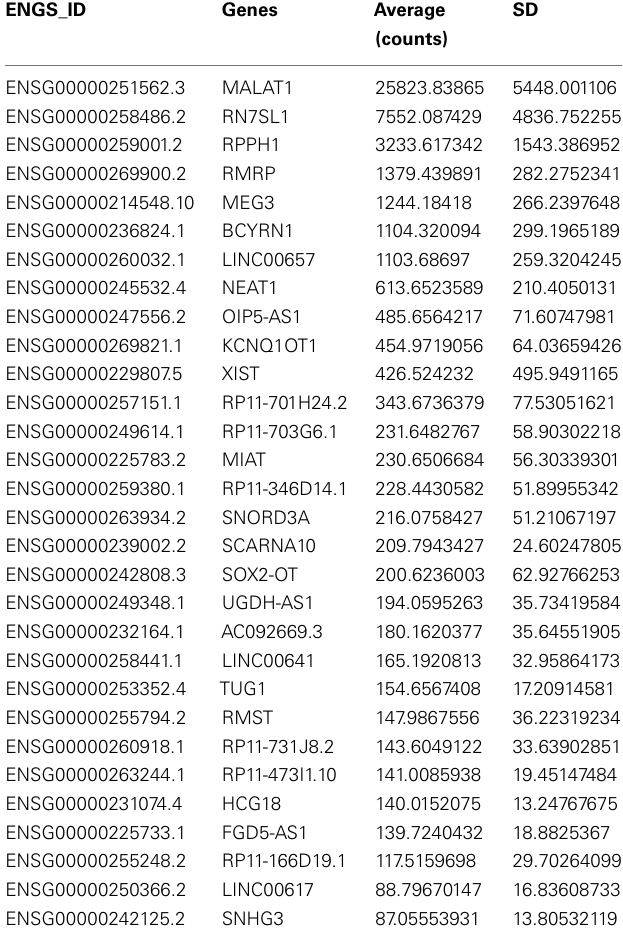
Table 1 | Most highly expressed lncRNAs in the human SEZ